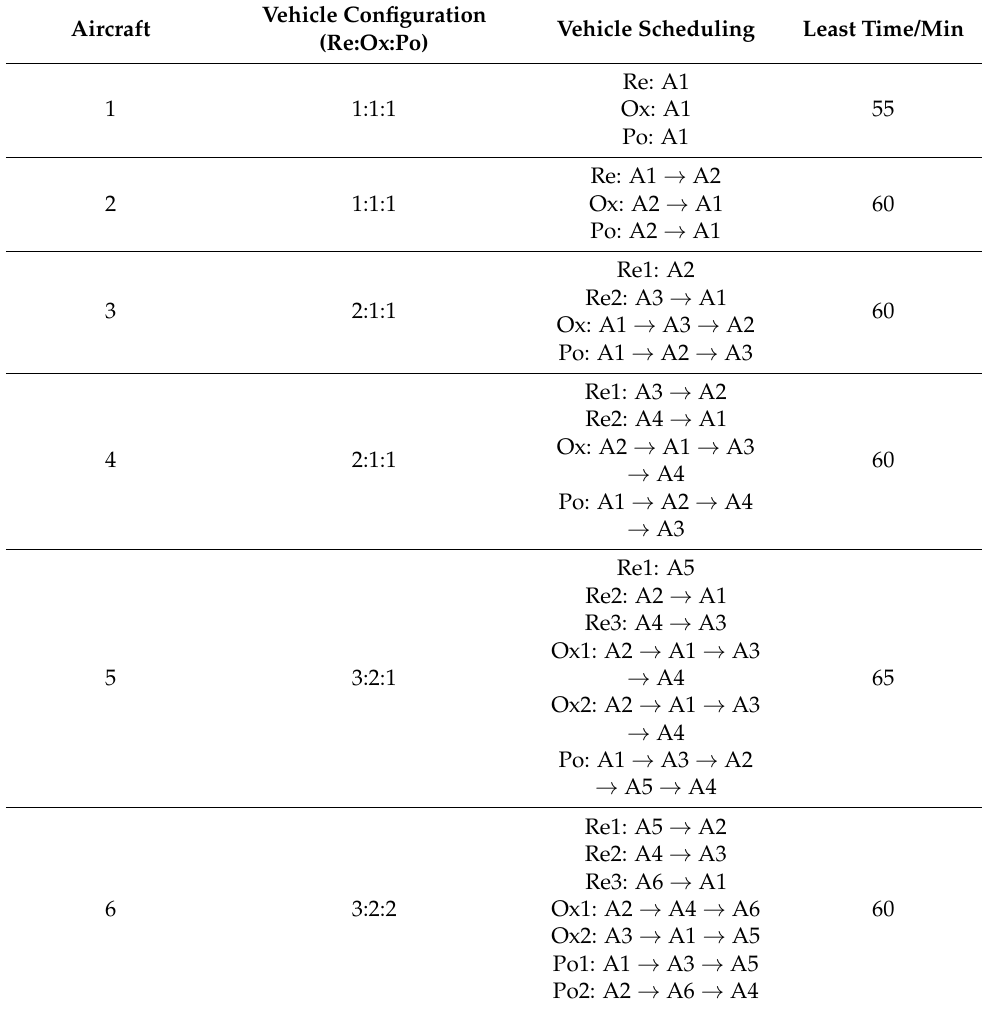
Table 9. Optimization scheme of airport apron support